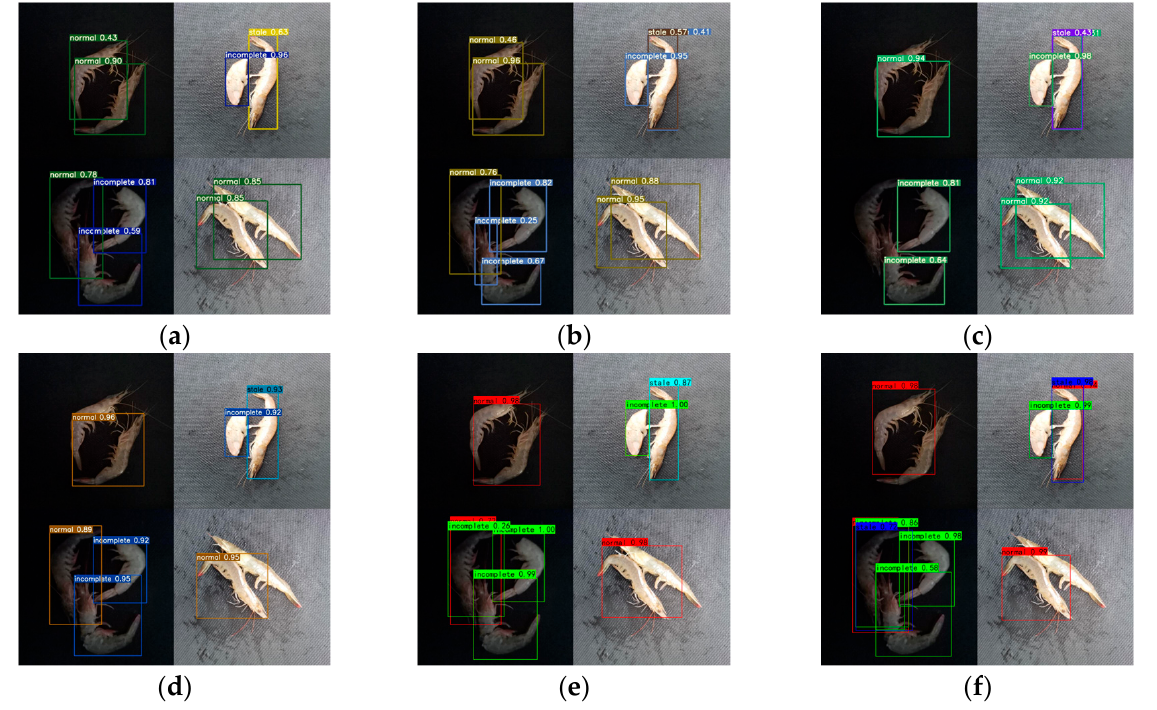
Figure 12. Prediction results for several models. The results predicted by the following models are shown: ( a ) Shrimp-YOLOv5s; ( b ) YOLOv5s, including seven correct detections, one false detection, and one overlapping detection; ( c ) YOLOv7-Tiny, including five correct detections, one false detection, two missed detections, and one overlapping detection; ( d ) YOLOX-Tiny, including seven correct detections and two missed detections; ( e ) SSD, including six correct detections and two missed detections; ( f ) Faster-RCNN, including five correct predictions, two missed detections, and two overlapping detections.